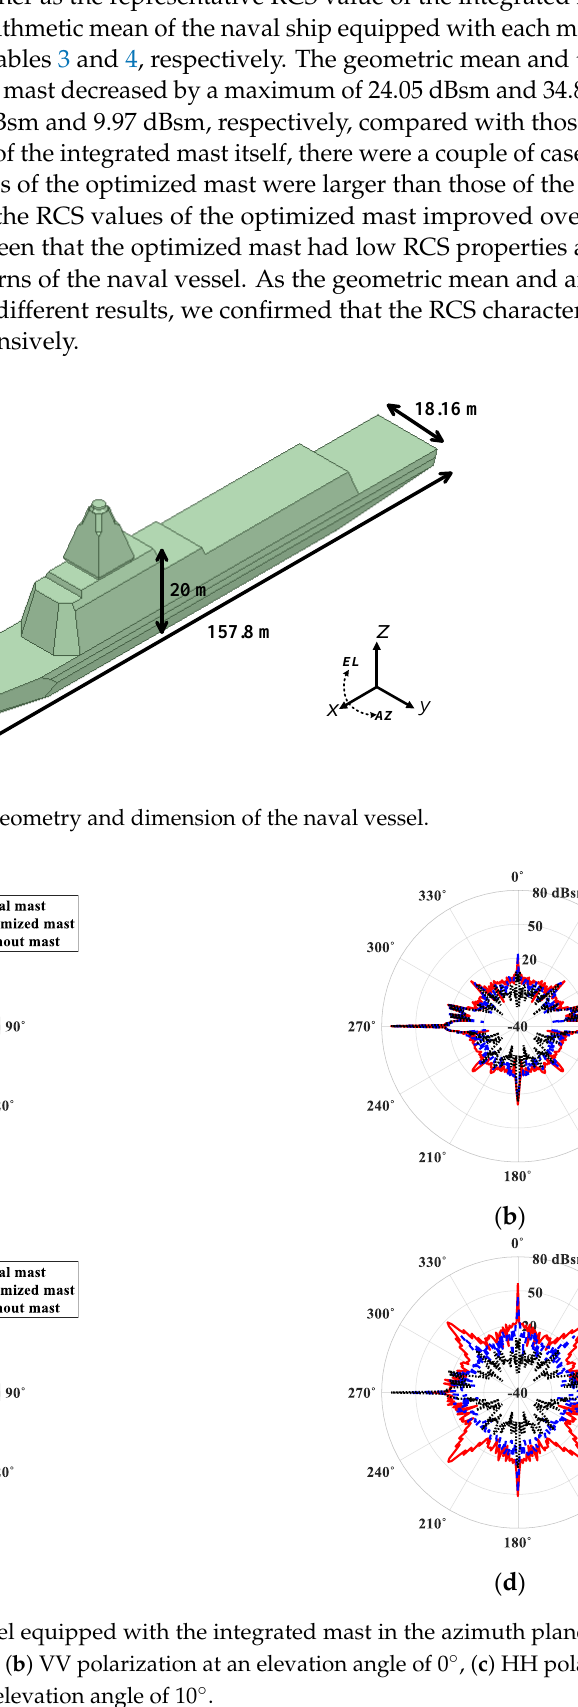
Table 2. Arithmetic mean of the integrated mast. (Unit: dBsm).